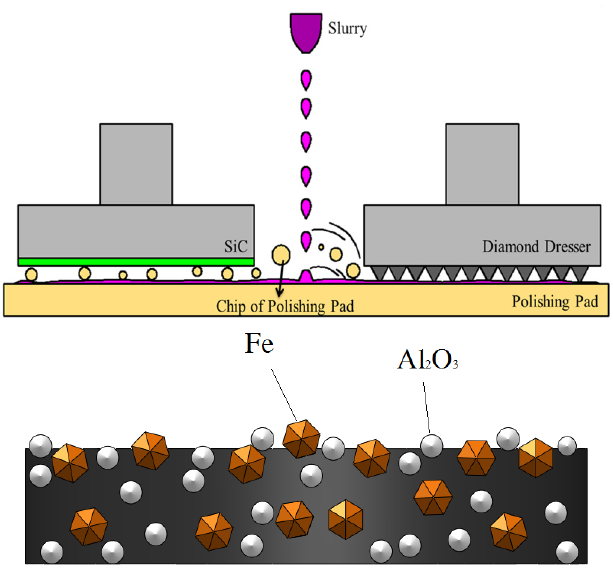
Figure 4. Schematic illustration for the Fe and Al 2 O 3 ‐ impregnated polyurethane polishing pads.